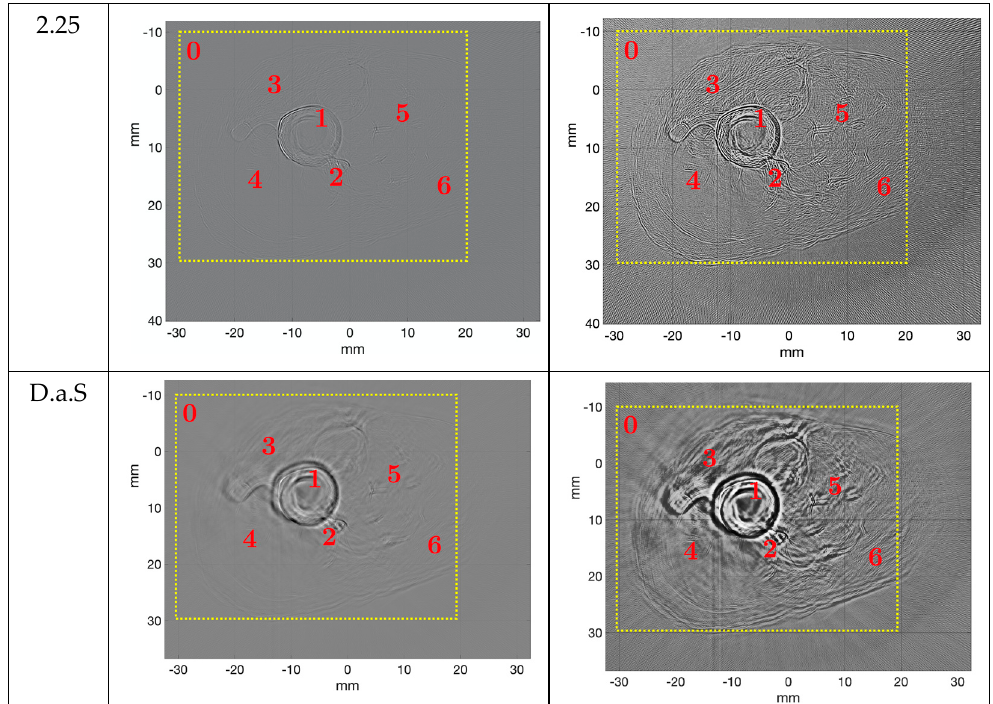
Figure 12. Reconstruction of the ex vivo chicken drumstick obtained using reflection-mode USCT algorithm in pulse-mode ( left ) and WCE-mode ( right ), with 720 signals and 65,536 samples per signal. Image size: 2048 × 2048 pixels 2 . The dotted square is the area where the contrast-to-noise ratio was calculated.